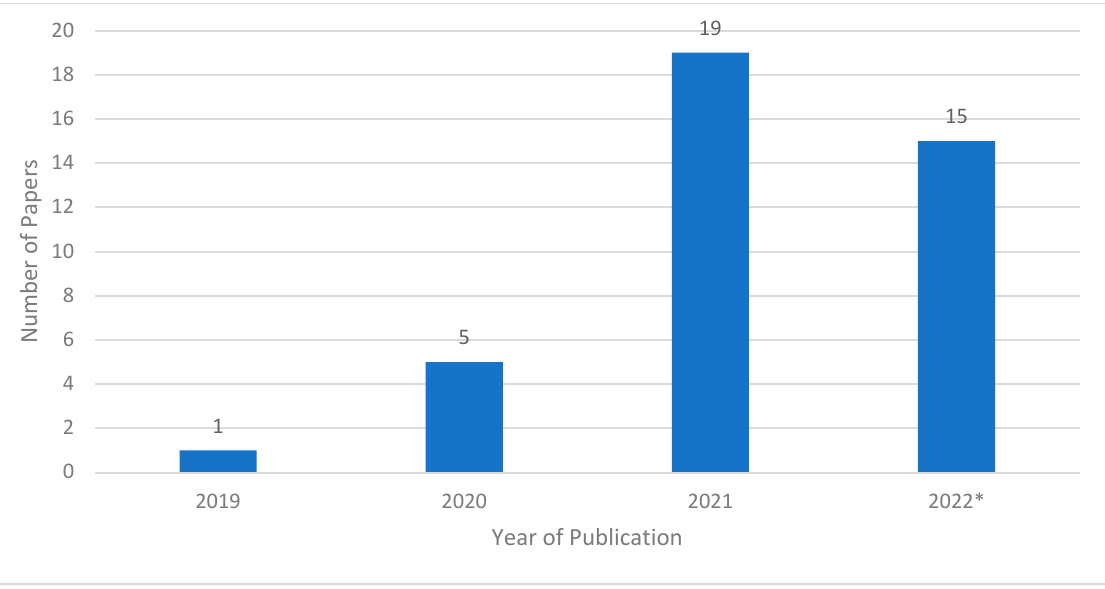
Figure 5. Annual trend of relevant papers published from 2019 to 2022. * On-going publications.